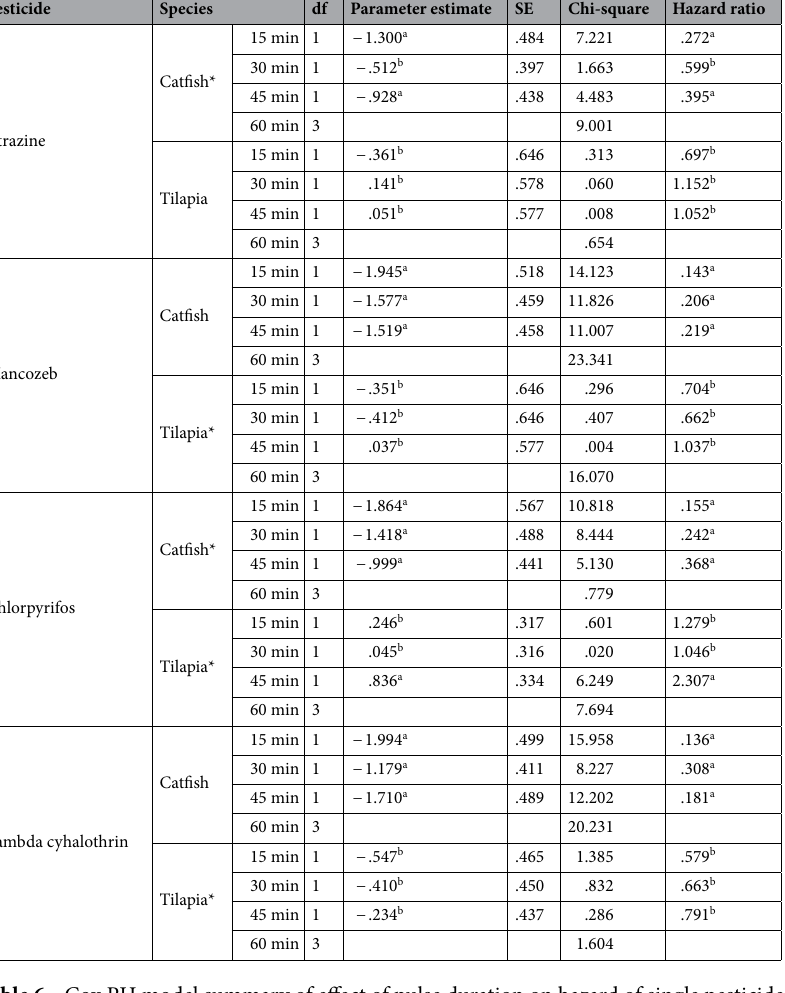
Table 6. Cox PH model summary of effect of pulse duration on hazard of single pesticide. *Hazard ratio constant with time. a Statistical significant ( p < 0.05). b Not significant ( p >